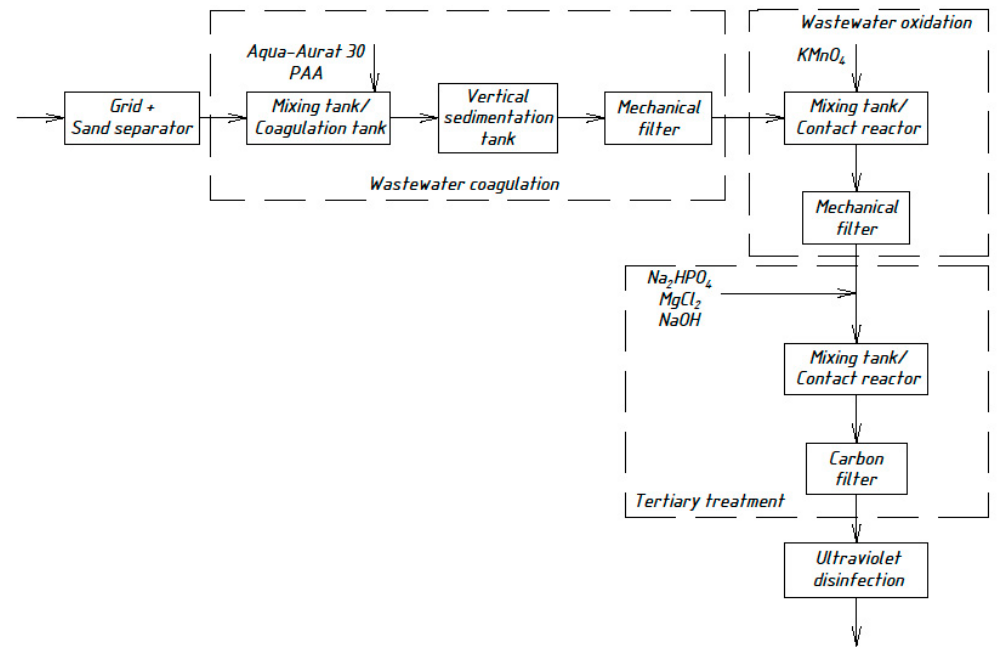
Figure 3. Wastewater treatment scheme with the chemical precipitation of organic nitrogen compounds.